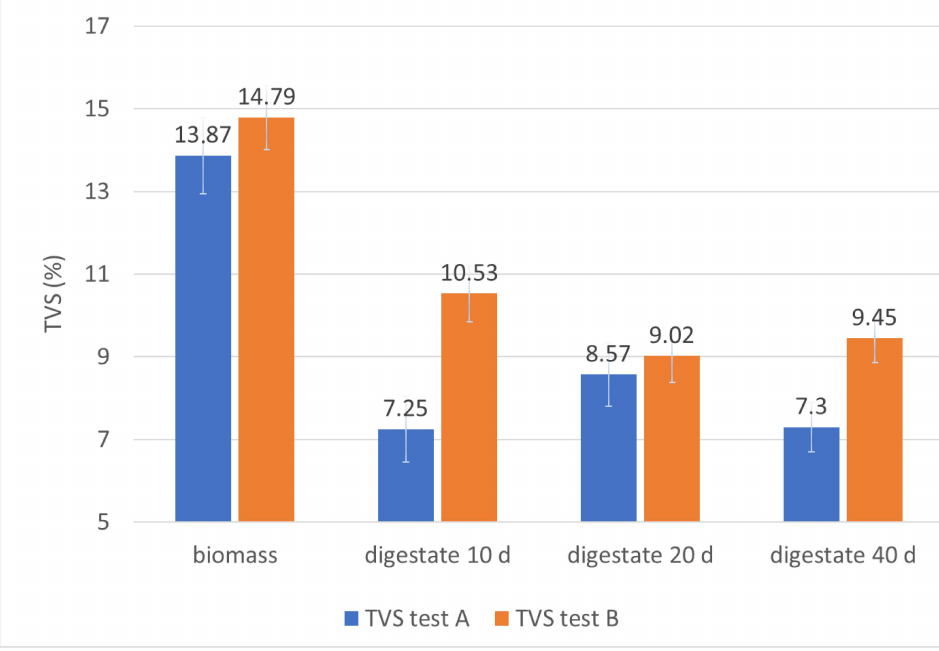
Figure 6. Monitoring of TVS in the digesters during the hydraulic retention